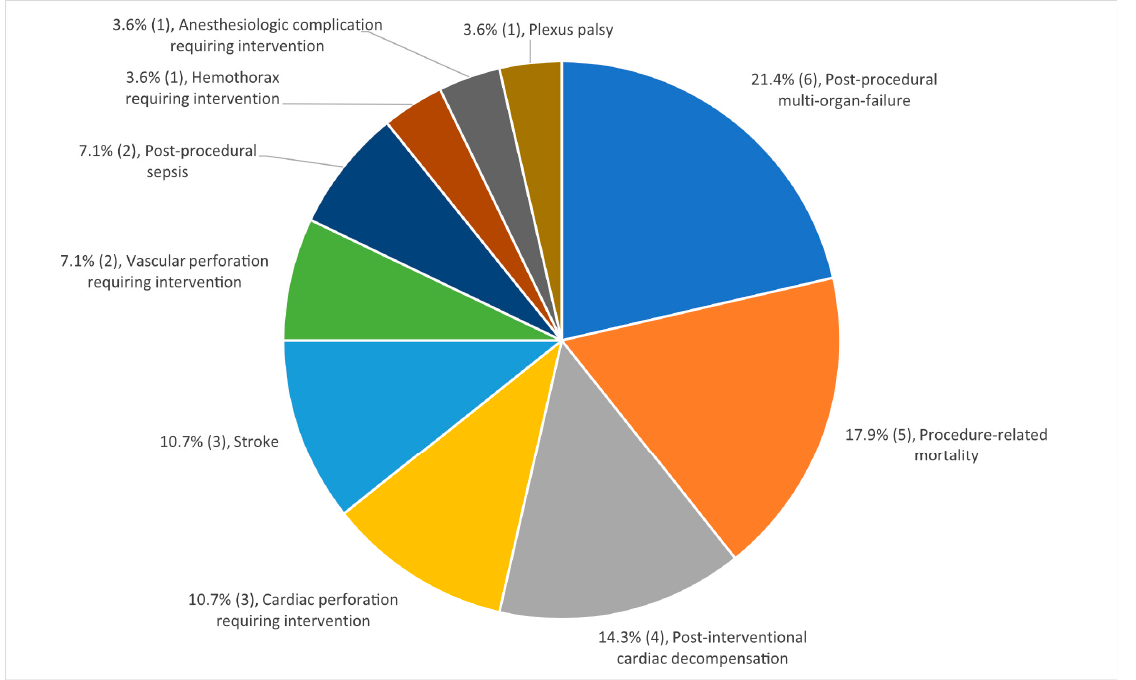
Figure 4. Frequency of major complications. Absolute number in relation to 350 TLEs in brackets. TLE: transvenous lead extraction. Table 3. Major